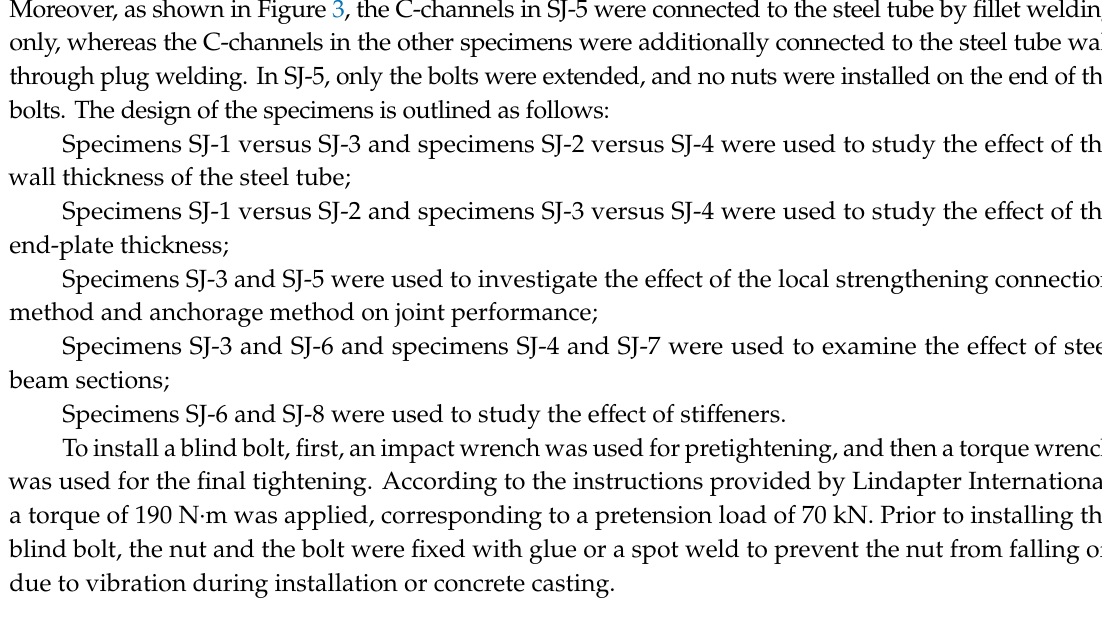
Table 1. Details of the test